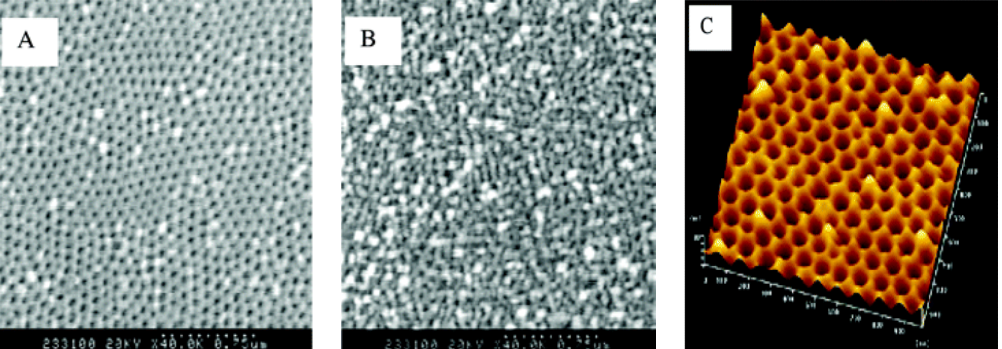
Figure 12. SEM images of the anodic alumina layer: ( A ) Top surface; ( B ) bottom surface. ( C ) AFM image of the top view of the barrier layer on the Al base. Reprinted with permission from reference [127]. Copyright 2004 American Chemical Society.